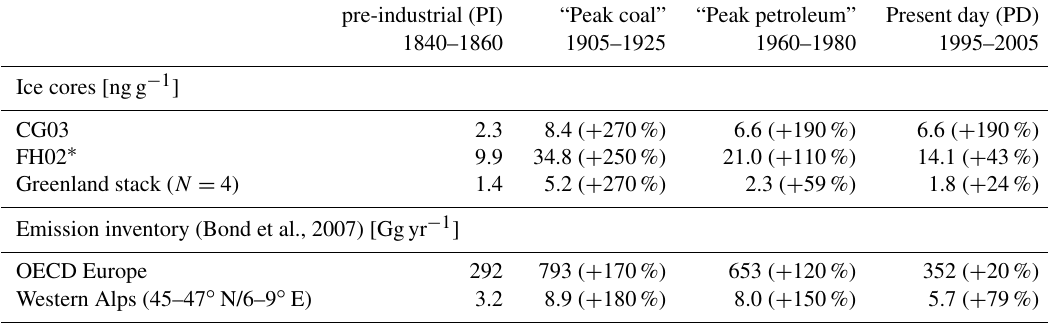
Table 3. Estimated BC emissions from Bond et al. (2007) for OECD Europe and Western Alps (45–47 ◦ N, 6–9 ◦ E) with median concen- trations of CG03 rBC and FH02 EC during pre-industrial (PI, 1840–1860), during peak coal burning (1910–1950), peak petroleum burning (1970–2000) and present day (PD, 1995–2005); numbers in brackets indicate the increase relative to PI (in %) (see Fig. 6).